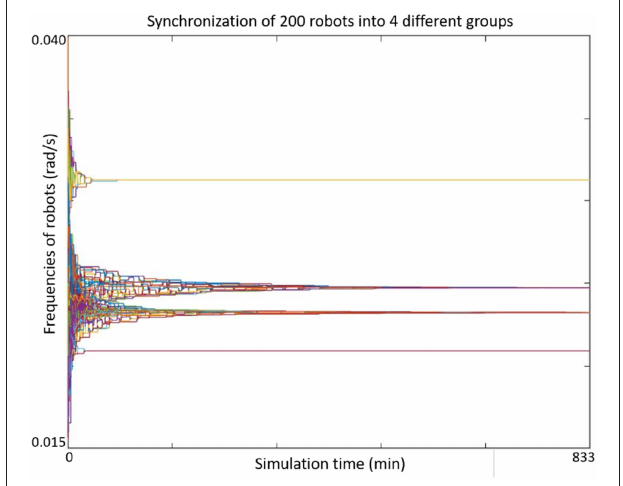
FIGURE 9 | Two-hundred agents converge to four subgroups.